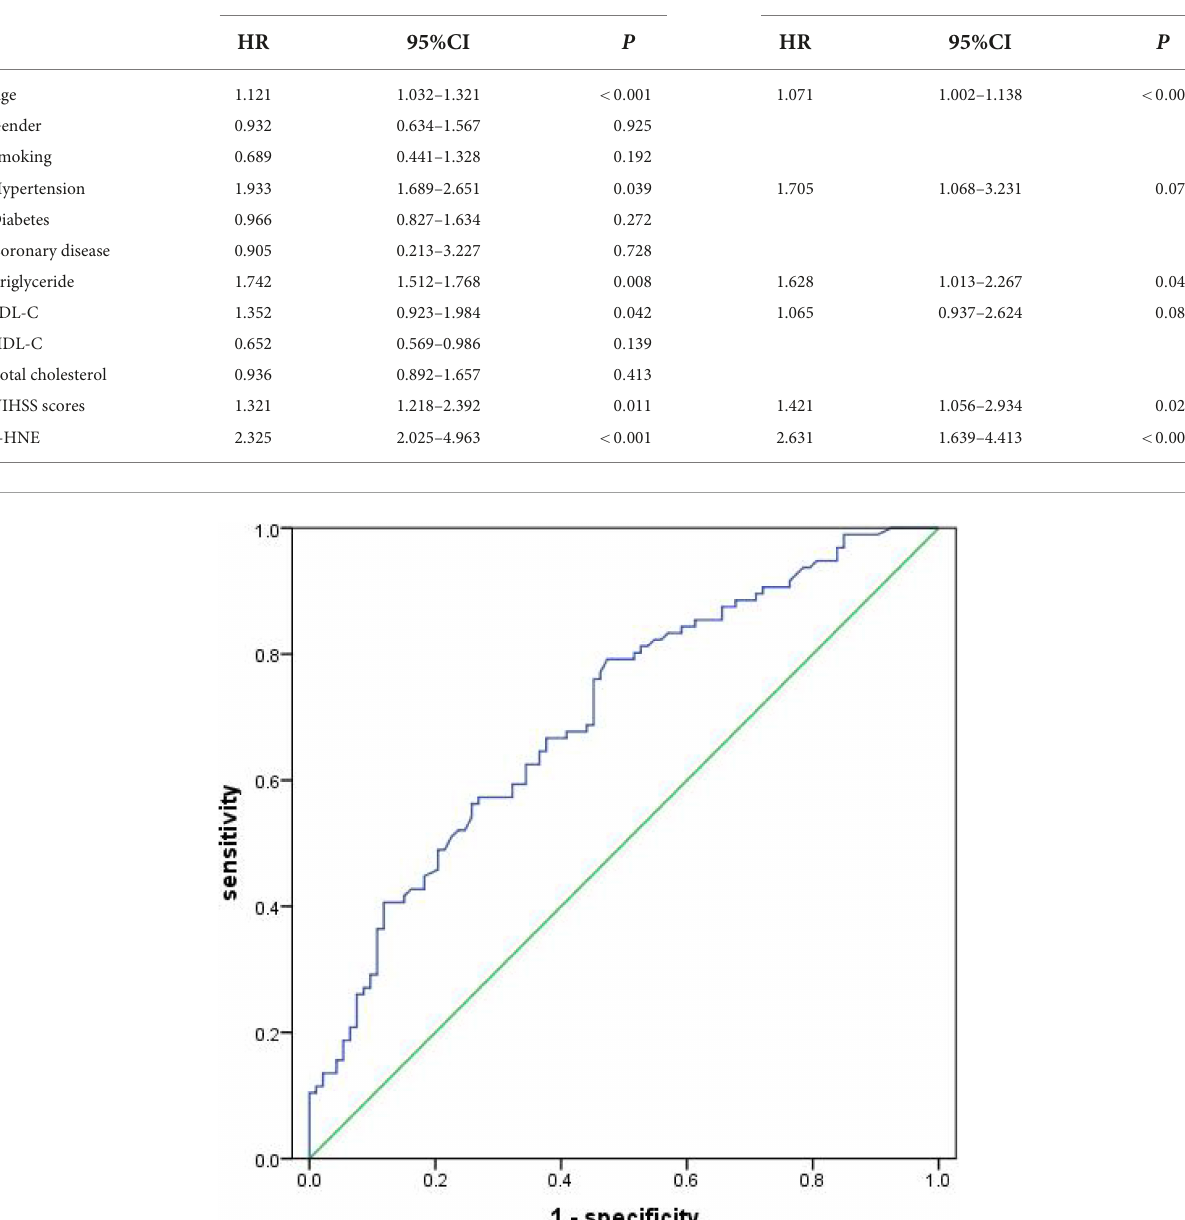
FIGURE4 Receiver operator characteristic curve demonstrating a predictive value of serum 4-hydroxynonenal (4-HNE) on recurrent cerebral infarction.